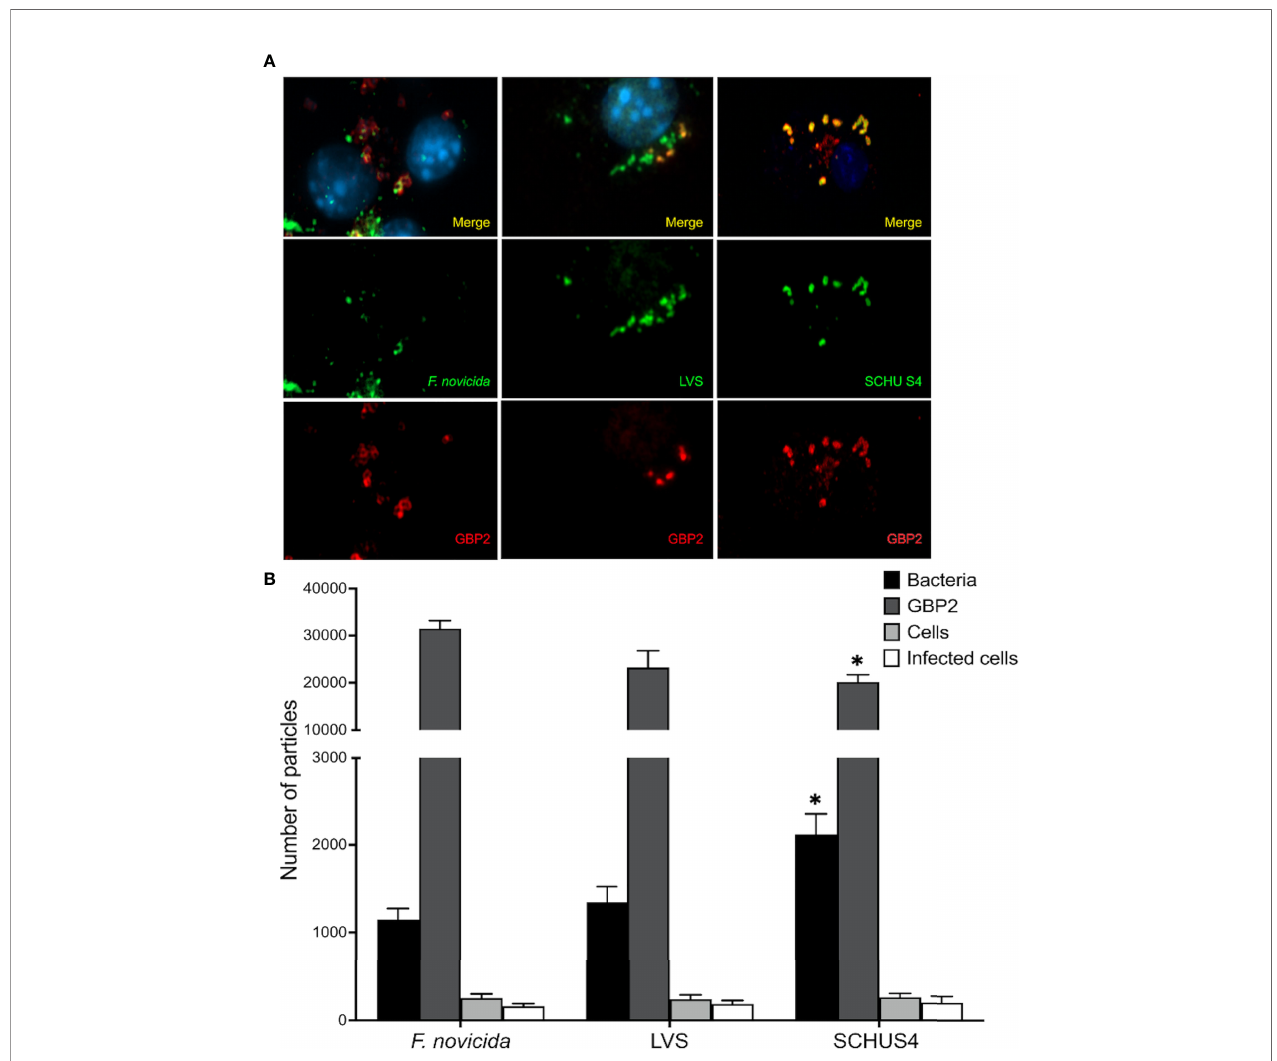
FIGURE 4 | Immuno fl uorescence staining of F tularensis (green), GBP2 (red), and DNA (blue) in IFN- g -treated BMDMs infected (MOI = 500) for 8 h with F novicida , LVS, or SCHU S4 (A) . Results for a representative experiment are shown in (B) . * P < 0.05 vs. F novicida -infected cultures.